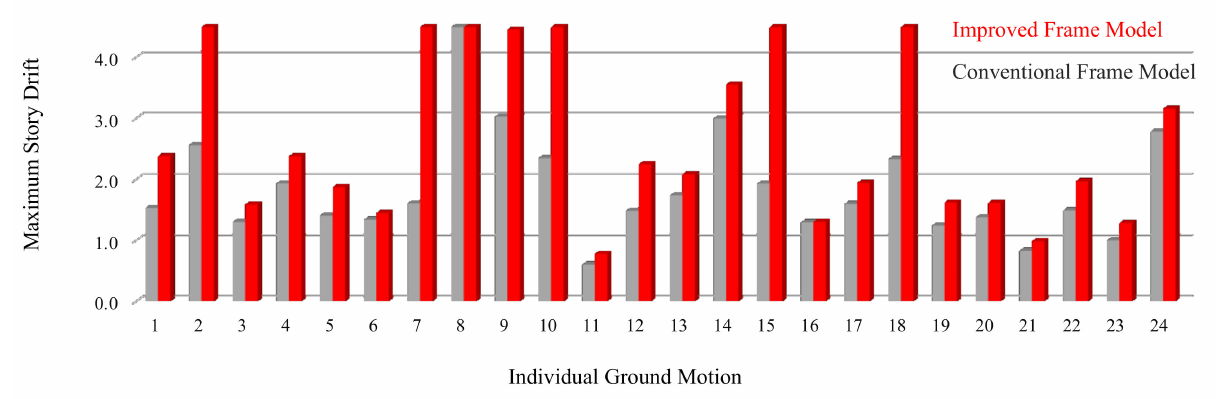
Figure 21. The maximum story drifts demand in individual ground motion for both conventional and improved frame models.